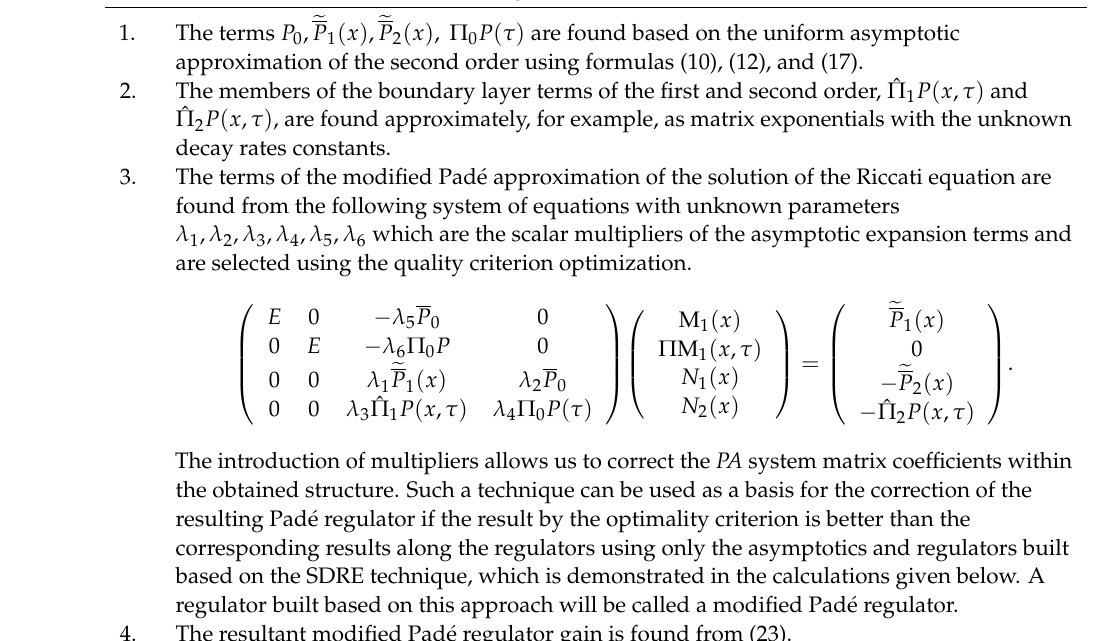
Algorithm 1: Discrete modified Pad é regulator construction.